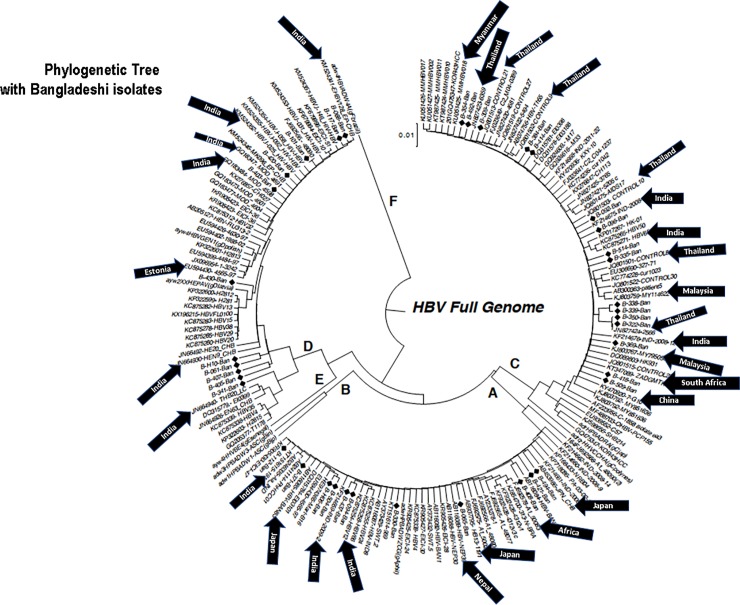
Phylogenetic tree constructed with 38 full genome sequences of hepatitis B virus from Bangladesh.The sequences of Bangladeshi isolates are shown in the phylogenetic tree indicated by black diamond markings. The countries that have close association with Bangladeshi HBV isolates are also indicated with an arrow and the name of the country.